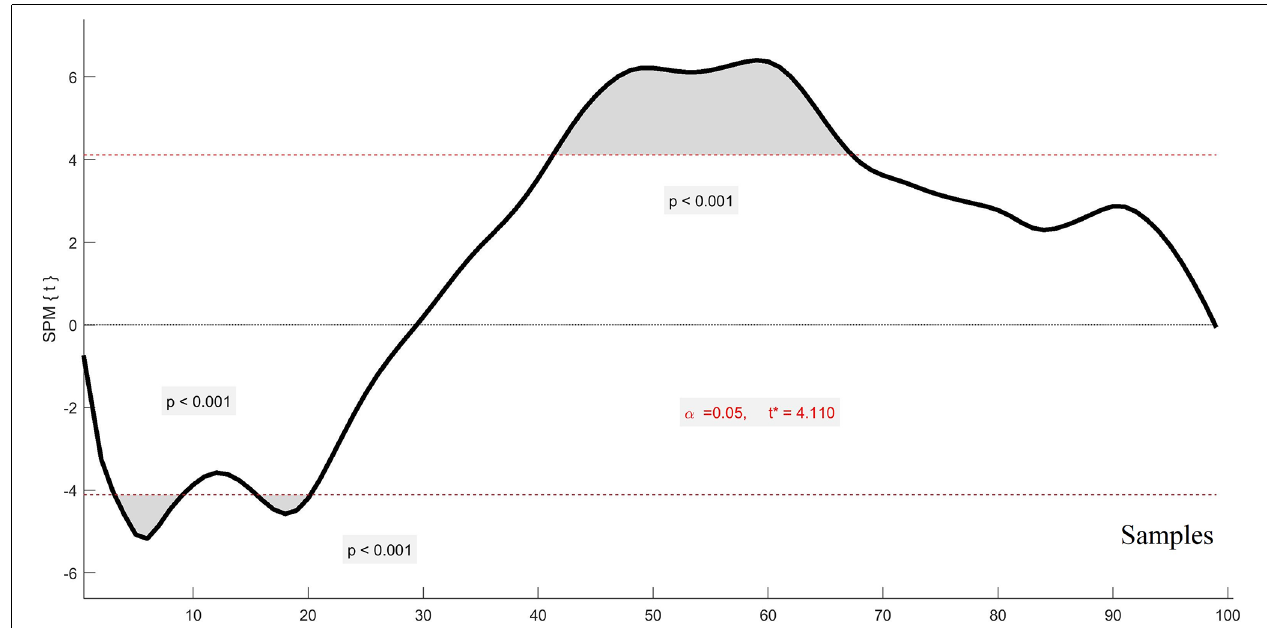
FIGURE 3 | An exemplary statistical parametric mapping (SPM) waveform displaying significant effects of wearing the H2 on the COP. The shaded areas represent portions of the COP waveform where statistically significant differences occurred. The p < 0.05 value is represented by the dotted lines at 4 and -4 on the ordinate. Perturbation onset occurred at 20 on the